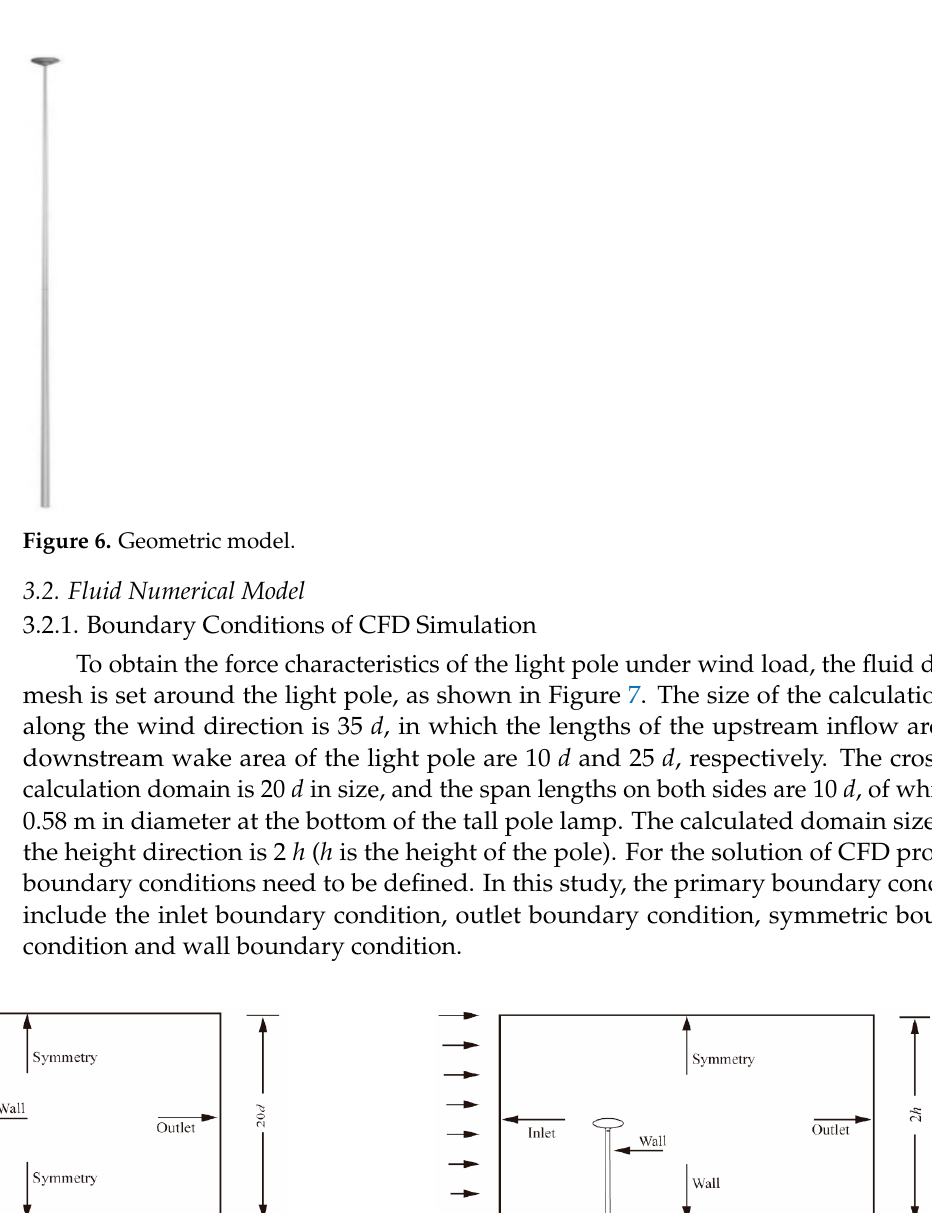
Figure 5. High pole lamp scene diagram.